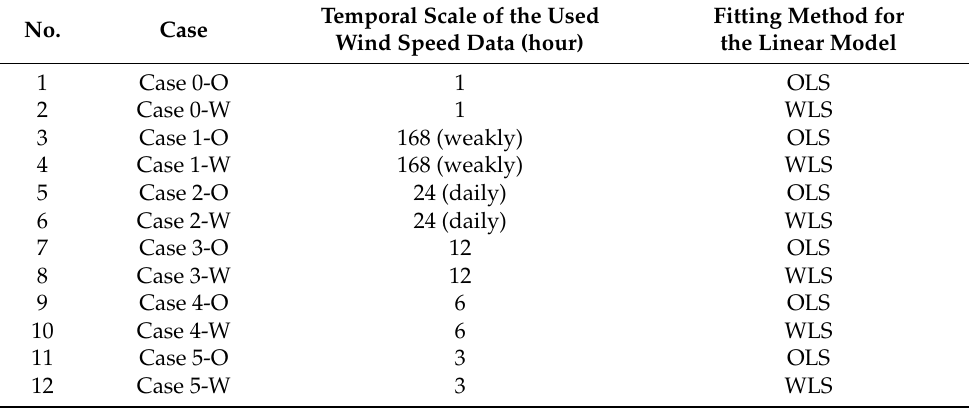
Table 3. Description of the test cases for the hourly mean wind speed